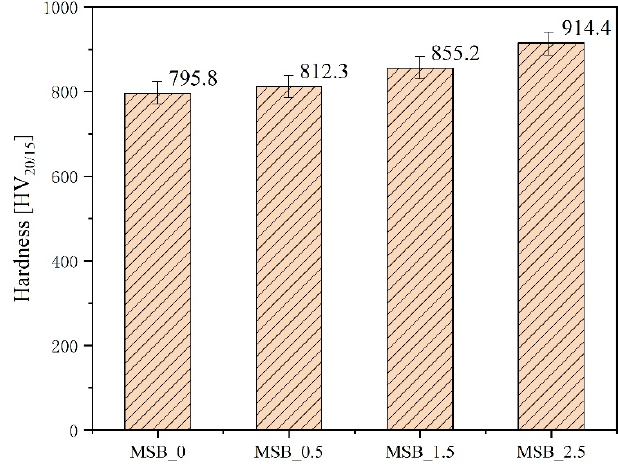
Figure 6. Mercury injection curves of four alloys: ( a ) MSB_0 alloy, ( b ) MSB_0.5 alloy, ( c ) MSB_1.5 alloy and ( d ) MSB_2.5 alloy.